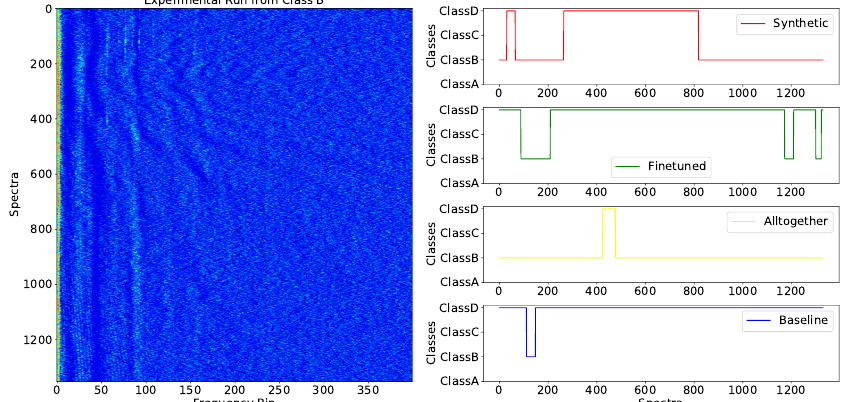
Figure 19. Convergence analysis for the LORO scenario for a given fold of class B. All four classifiers are shown, namely, synthetic, fine-tuned, all together, and baseline. Class assignment is shown by the corresponding continuous voting process for an incoming beam formed